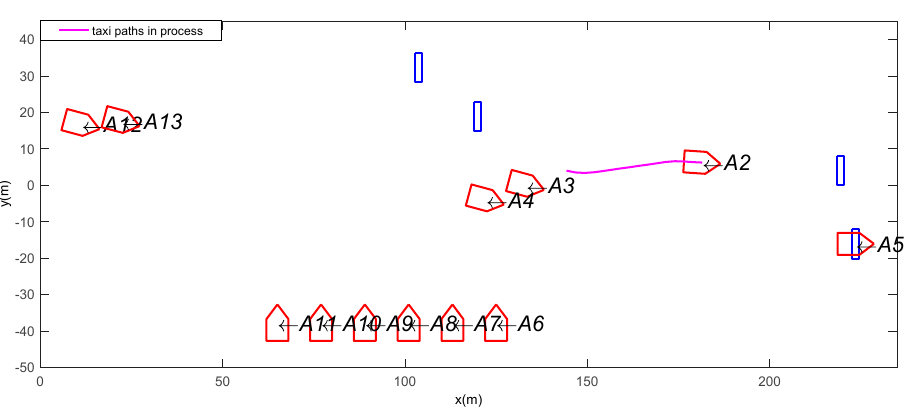
Figure 16. The state of aircraft when t = 30 s.